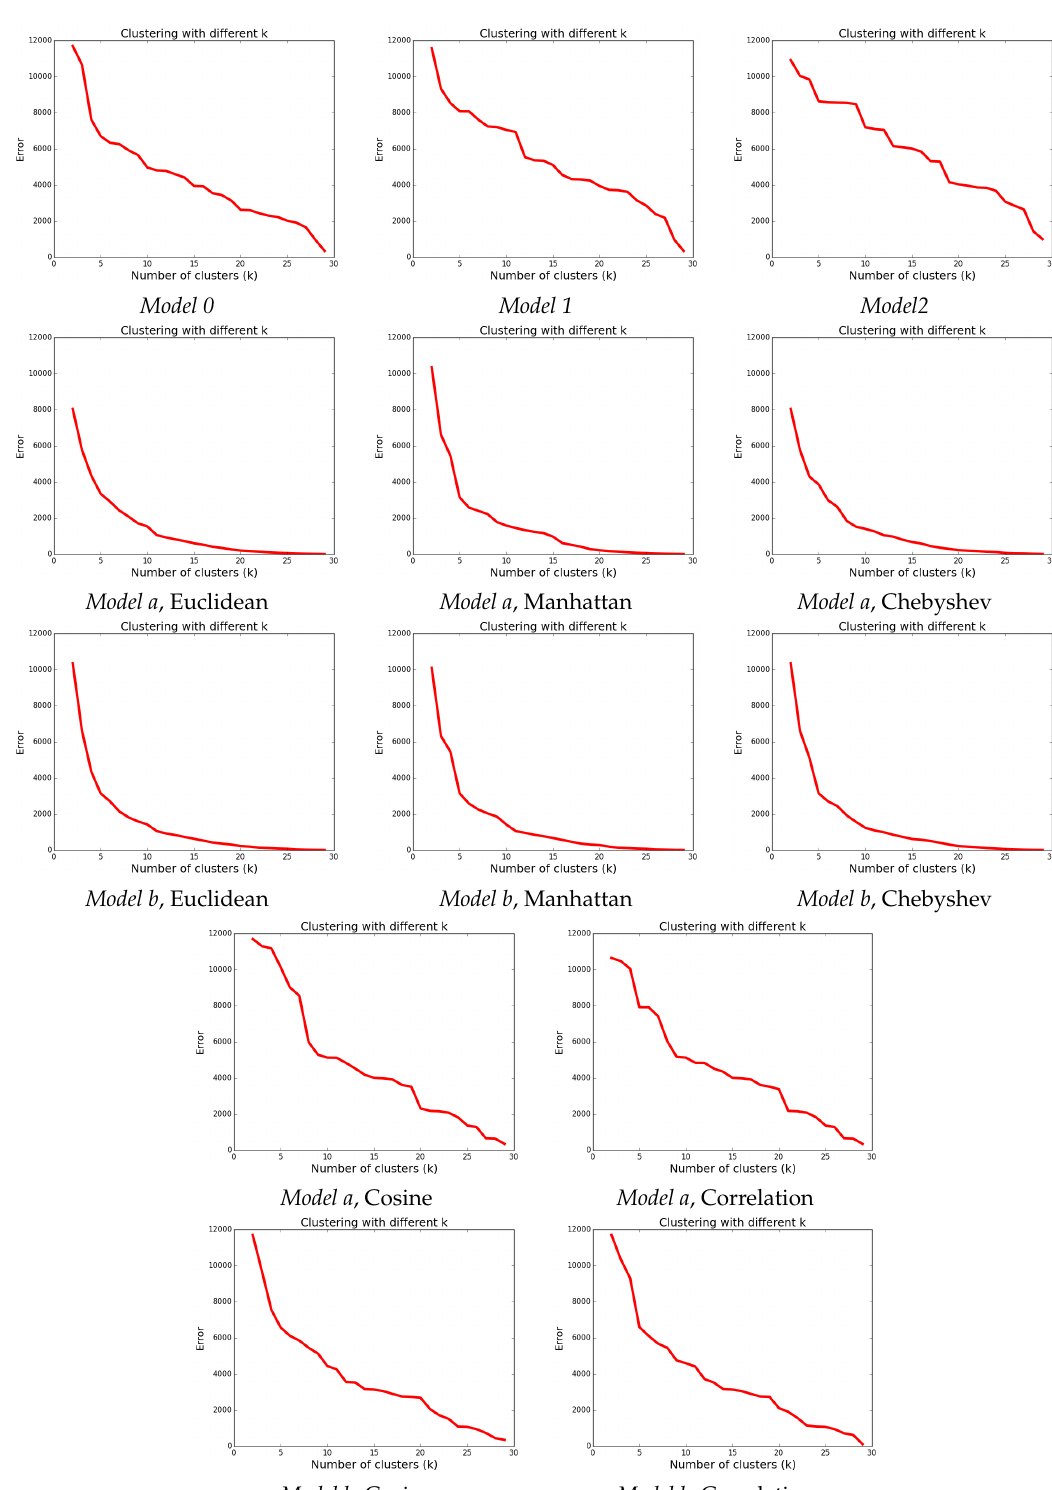
Figure 4. Distance against number of clusters for the complete linkage